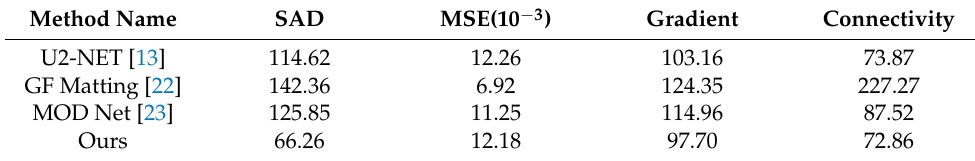
Table 1. Comparison of the results of several methods on the PPM-100 test set.